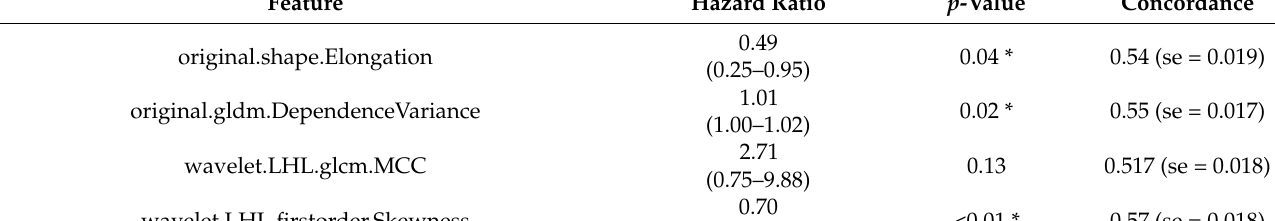
Table 2. Univariate Cox regression analysis to identifying the radiomics signatures in the training set. Feature p